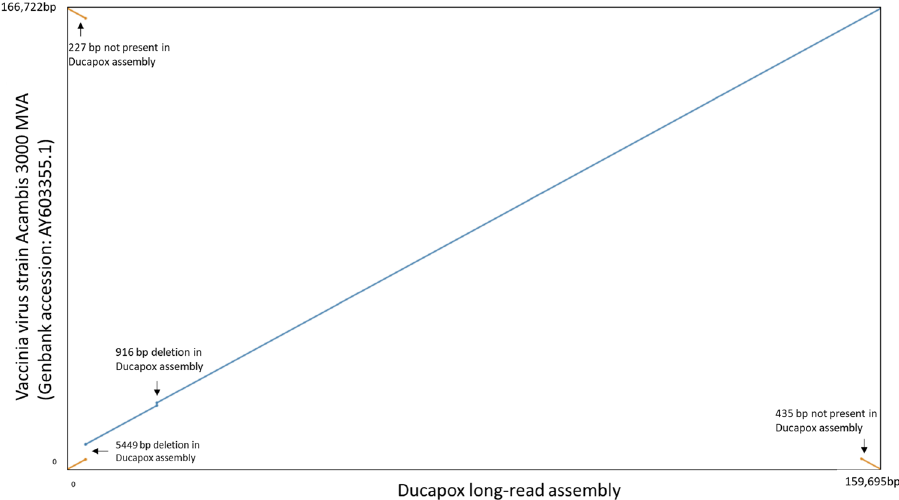
Figure 2. Dotplot comparison of the Ducapox long read assembly vs the closest matching viral genome, that of VACV Acambis 3000 MVA. Genomic deletions of 5449 bp and 916 bp in size are illustrated. The VACV Acambis 3000 MVA was also found to be 227 bp and 435 bp longer at its ends, with respect to the Ducapox